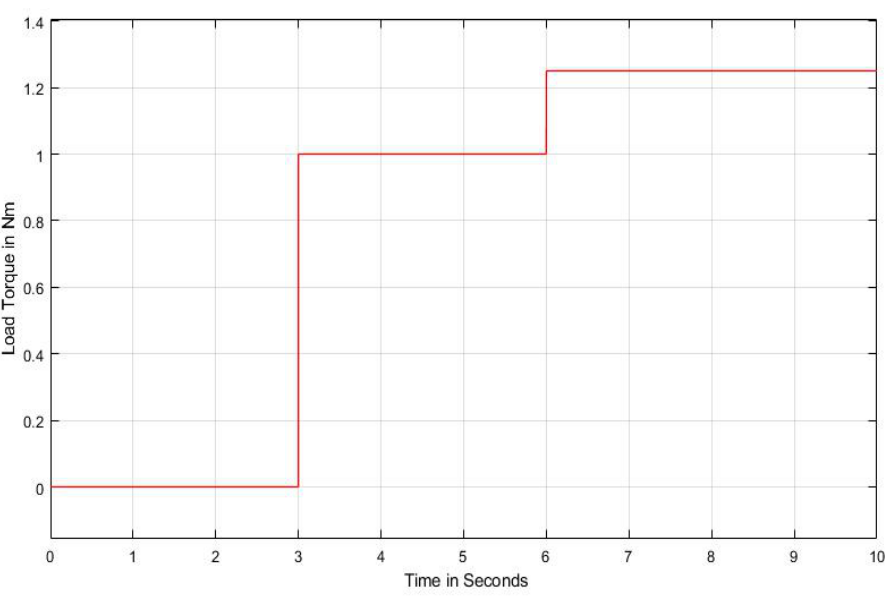
Figure 15. Load torque vs. time.